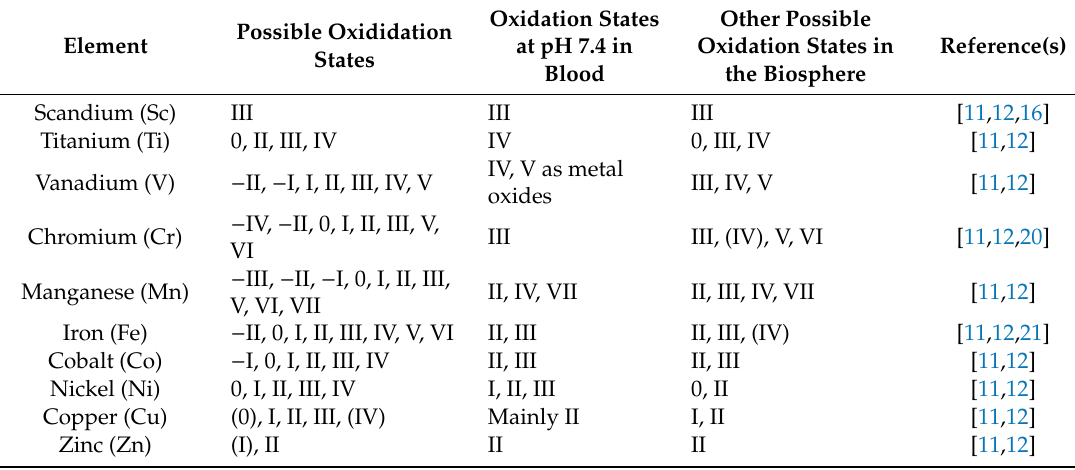
Figure 3. Demonstration of the diversity of metal chemistry. ( a ) Oxidation state affects chemistry, as V(IV) is a blue solution and solid, while V(V) is a colorless solution and white powder; ( b ) chloride salts of the first-row transition metals have different colors. Shown are mainly the oxidation state (II) and (III) metal complexes CrCl 3 , MnCl 2 , FeCl 3 , CoCl 2 , NiCl 2 , CuCl 2 , and ZnCl 2 with varying amounts of hydration. Table 2. Possible oxidation states and likely oxidation states in blood at pH 7.4 and under other biological conditions of first-row transition metals, where oxidation states in parentheses indicate rare but possible